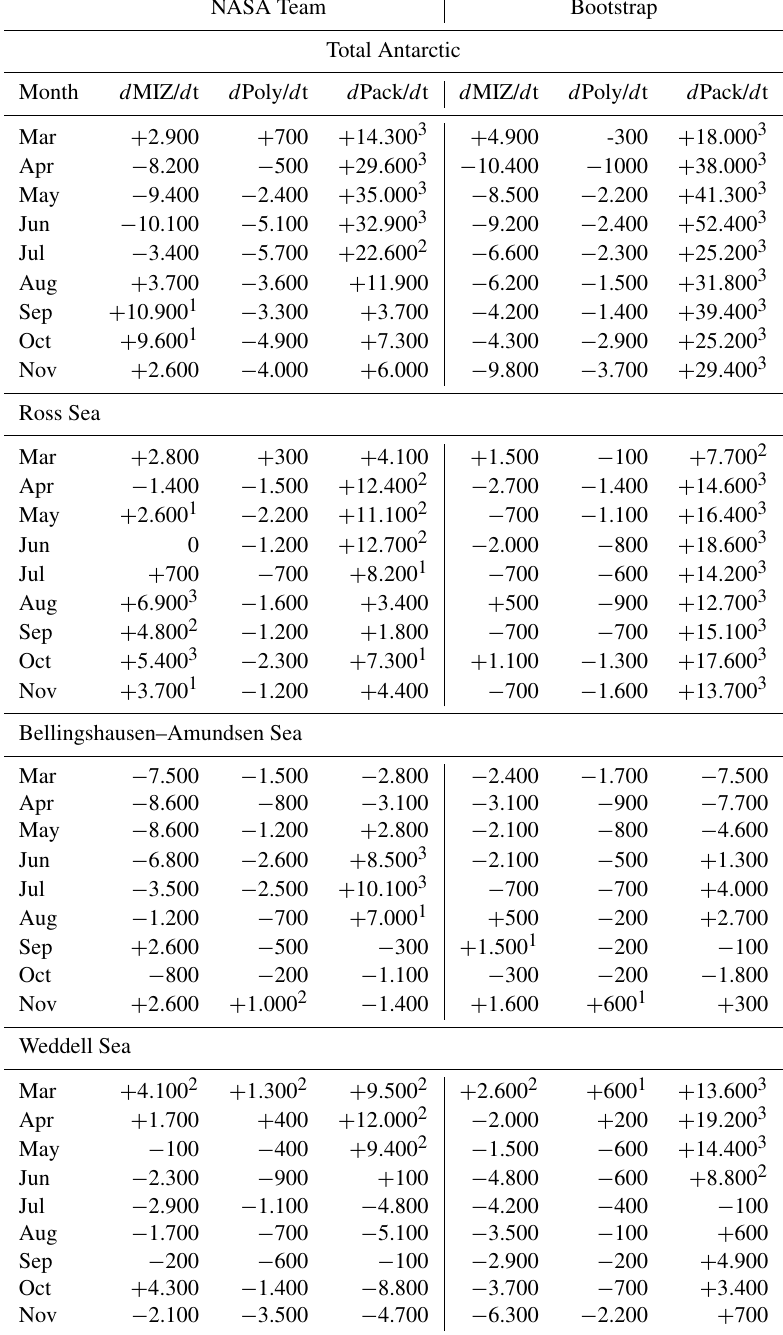
Table 3. Comparison of trends in the marginal ice zone, polynyas and the consolidated pack ice for March through November (1979 to 2013) for both the NASA Team and Bootstrap sea ice algorithms. Trends are computed in square kilometers per year (km 2 yr − 1 ). Statistical significance at the 90th, 95th and 99th percentiles are denoted by 1 , 2 and 3 , respectively. Results are only shown for March through